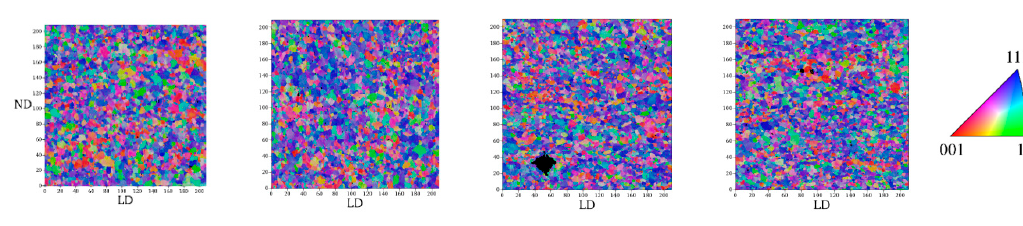
Figure 10. IPF color maps (ND direction) corresponding to the four EBSD measurements performed on the deformed microstructure (uniaxial tension, 15% deformation).